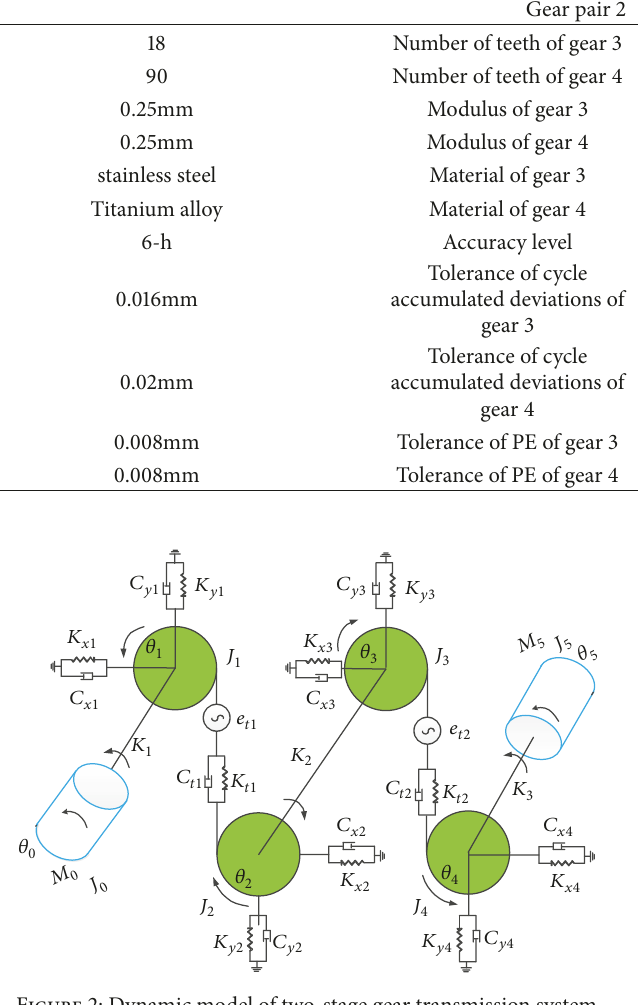
Figure 2: Dynamic model of two-stage gear transmission